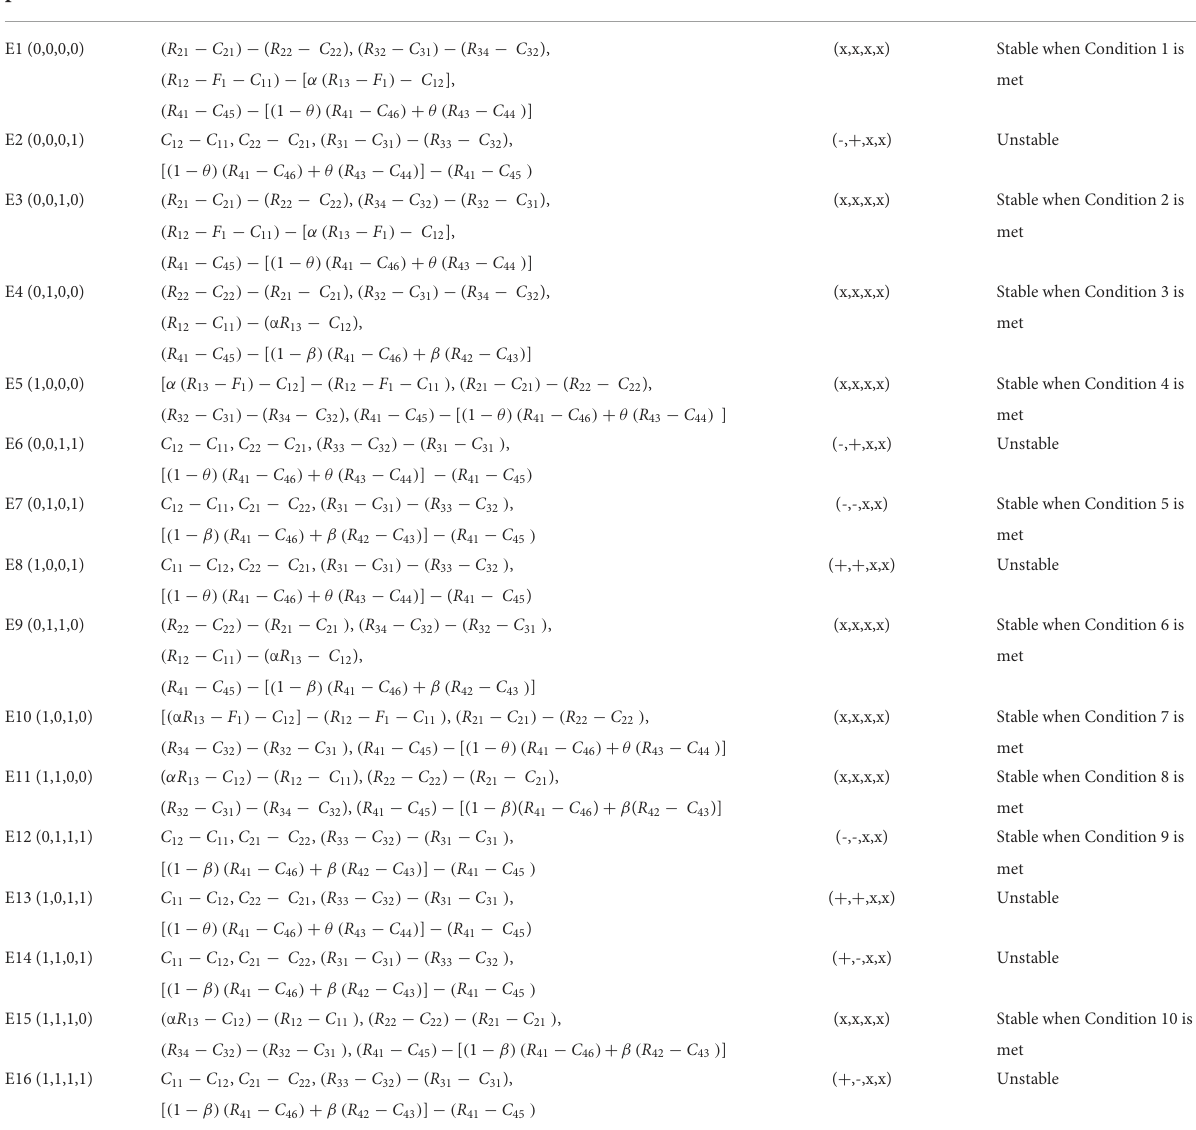
TABLE 3 Asymptotic stability analysis of potential equilibrium